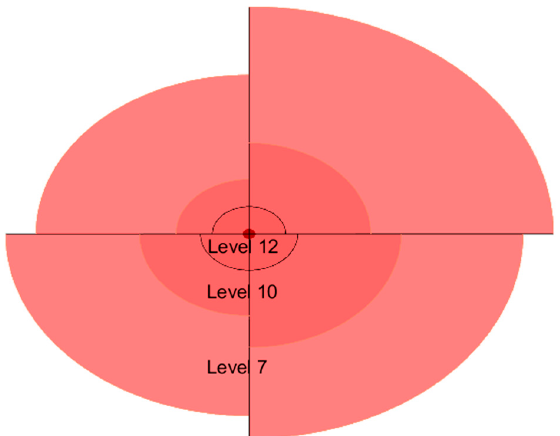
Figure 12. A typical typhoon’s wind circle radii; the higher the level value, the larger the wind speed and the closer to the center of the typhoon.